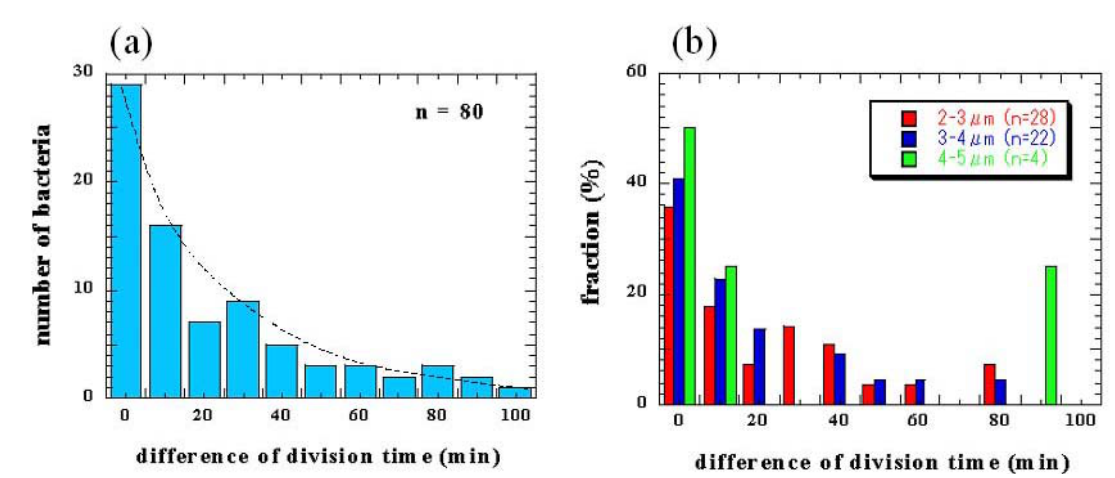
Figure 11. ( a ) Differences in division time for two daughter cells of same mother cells (n = 80 pairs), and ( b ) initial dependence of division time differences on